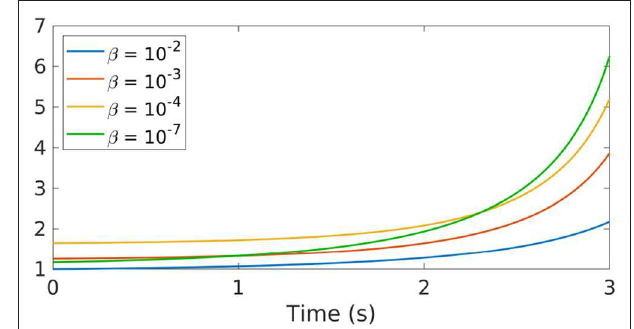
FIGURE 3 | Control function applied to the Kuramoto model [Equation (5)] with N